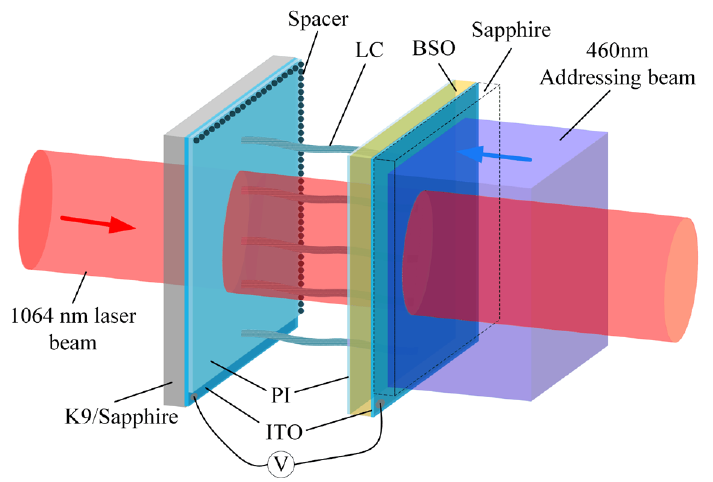
Figure 1. OASLM structure illustration. PI: polyimide, ITO: indium tin oxide, LC: liquid crystal, BSO: Bi 12 SiO 20 crystal.